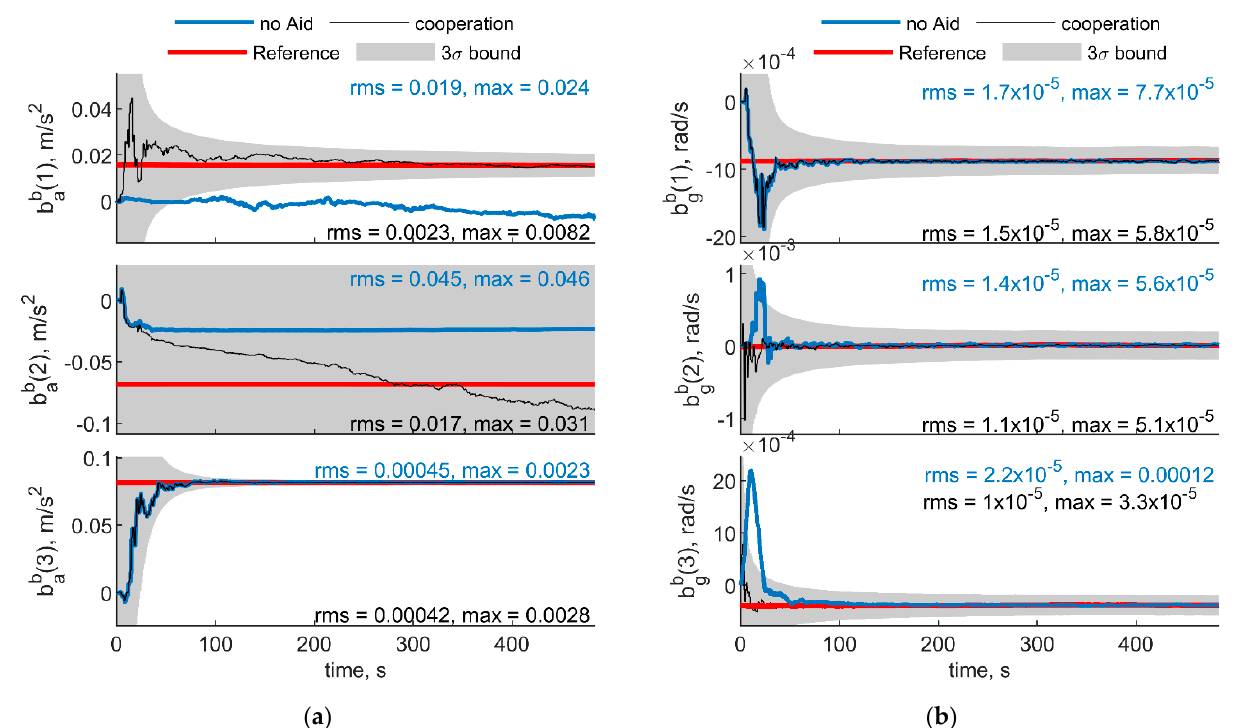
Figure 11. ( a ) Accelerometer and ( b ) gyroscope biases predicted by the filter. Chief trajectory is reported in Figure 3. One deputy, r = 100 m, μ = 0°, χ = 0°. Reference value is reported in red. Results obtained with cooperation and without cooperation have been reported in black and blue, respectively. RMS and maximum error value have been evaluated starting from t = 60 s.